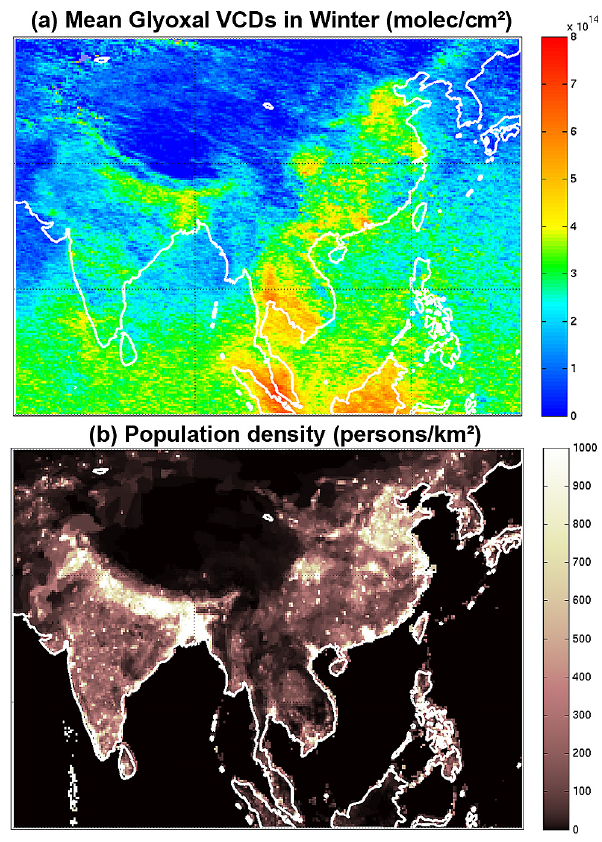
Fig. 11. Illustration of the mean glyoxal VCDs in winter (December-January-February) (upper panel) and the population density (lower panel) in southeastern Asian regions. The popula- tion density data are taken from the GPW v3 data set (Balk and Yetman,